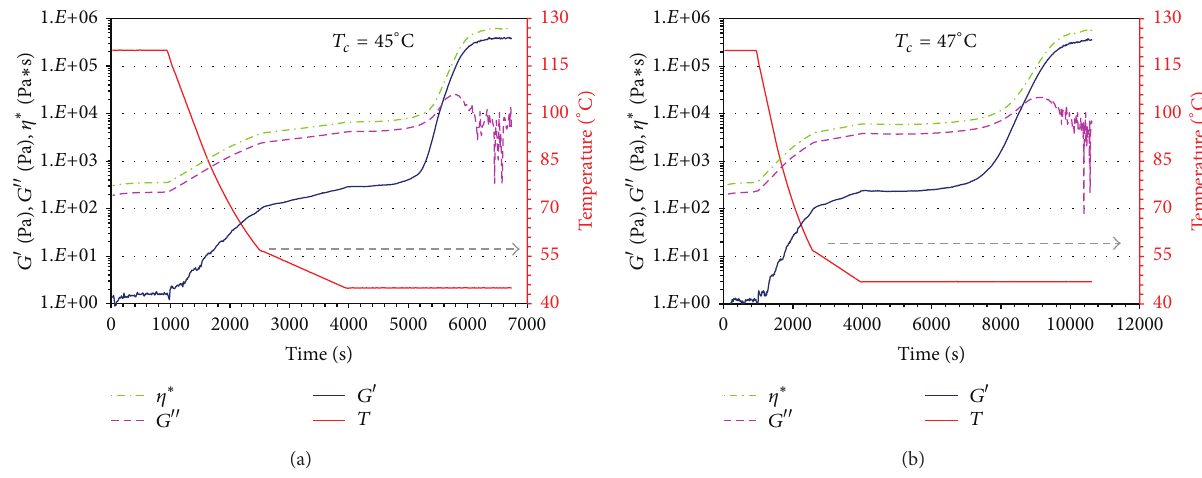
Figure 8: (a) Rheological measurements of the polycaprolactone crystallization at 45 ∘ C: storage modulus G 󸀠 , loss modulus G 󸀠󸀠 , complex viscosity 𝜂 ∗ , and temperature measured simultaneously under constant stress of 100Pa and constant frequency of 0.1rad/sec. (b) Rheological measurements of the polycaprolactone crystallization at 47 ∘ C: storage modulus G 󸀠 , loss modulus G 󸀠󸀠 , complex viscosity 𝜂 ∗ , and temperature measured simultaneously under constant stress of 100Pa and constant frequency of 0.1rad/sec.